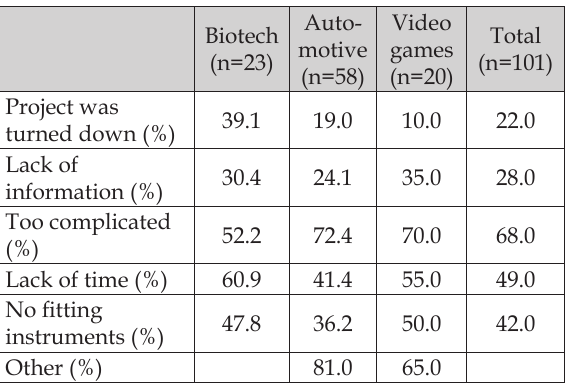
Table 4. Problems that caused non-funding in differ- ent industries.